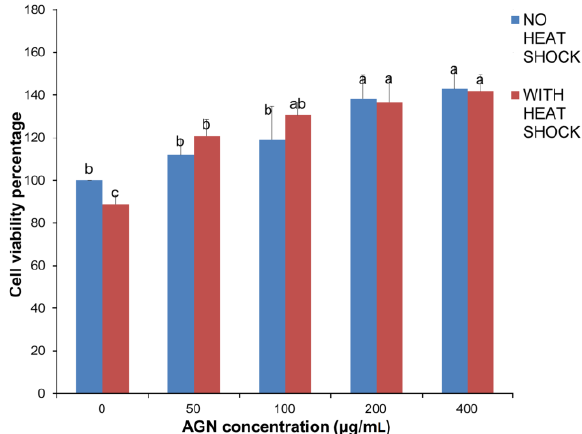
Figure 2. Angelica gigas Nakai root hot water extract promoted cell proliferation on cells subjected to normal incubation temperature (37°C) and alleviates heat shock by both cytotoxicity prevention and dose dependent cell proliferation among 3T3-L1 cells incubated for 48 hours. The results are expressed as mean± standard deviation. Bars with different superscript were significantly different